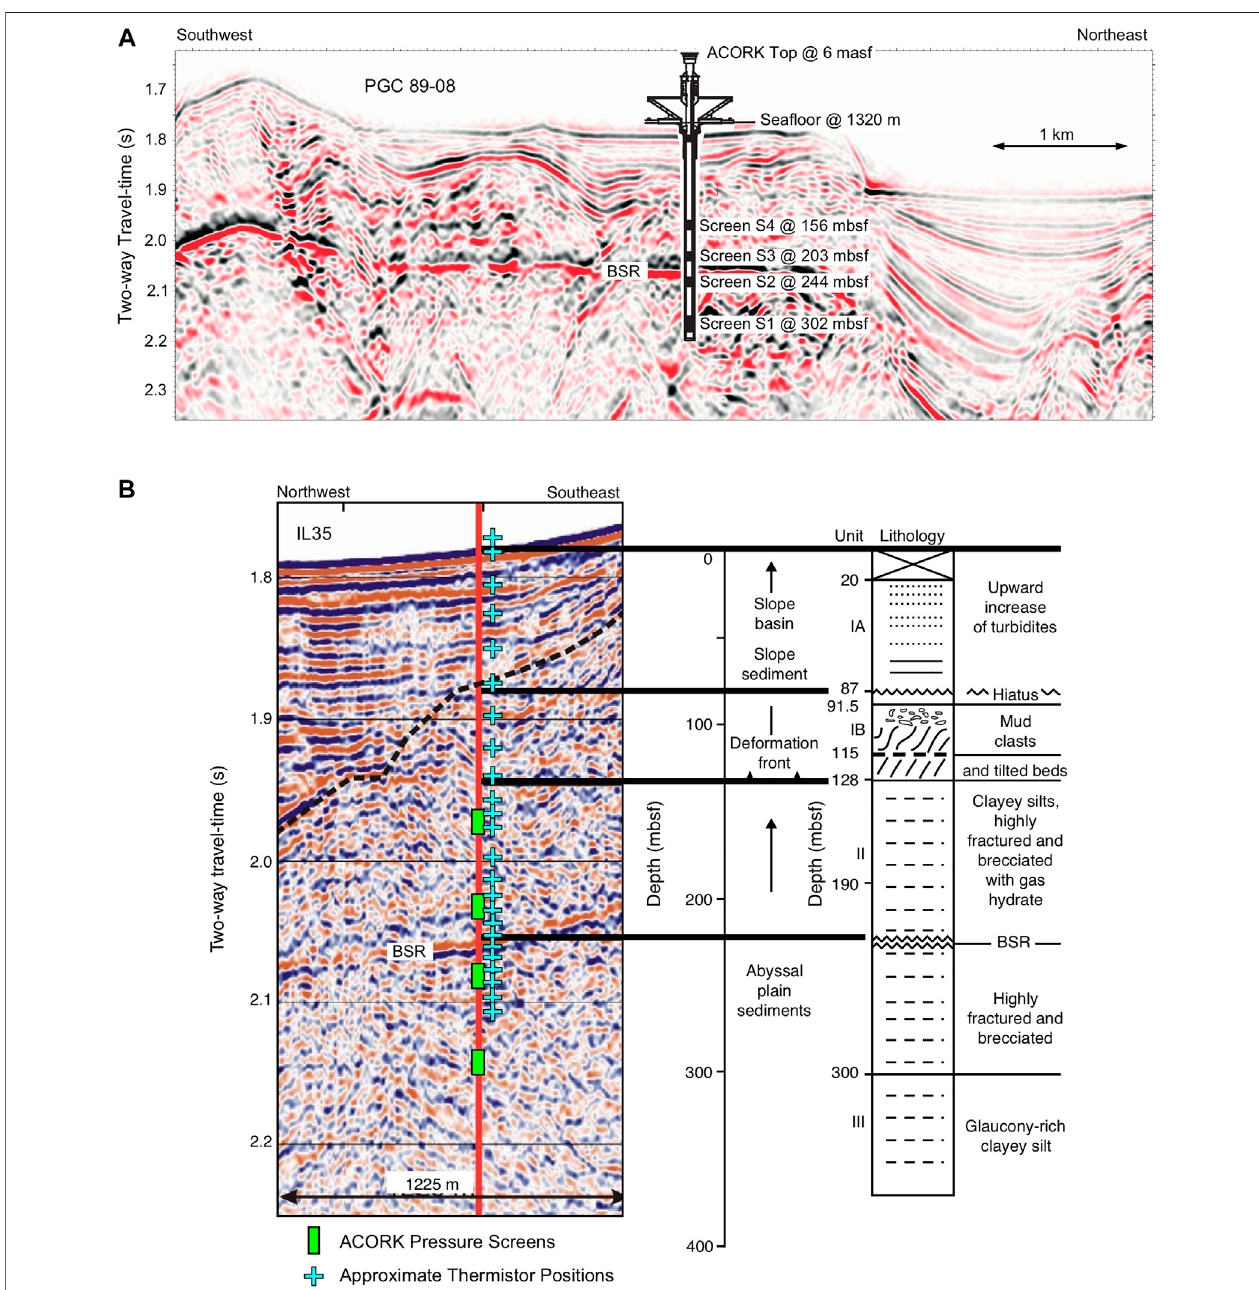
FIGURE3|(A) ExpandedviewofthePGC89-08seismicimagehighlightedin Figure1B ,showingBSRandcon fi gurationoftheACORKinHoleU1364Aincluding its four downhole pressure-monitoring screens. (B) Position of Hole U1364A (red vertical line) on seismic cross line IL35 correlated with lithology derived from core samplesatSites899andU1327A.ApproximatepositionsofACORKpressuremonitoringscreensandthermistorcablesensorsareshownasgreenrectanglesandblue crosses, respectively, with exaggerated vertical scales. (A) and ( B ) are both modi fi ed from Expedition 311 Scientists (2006b).